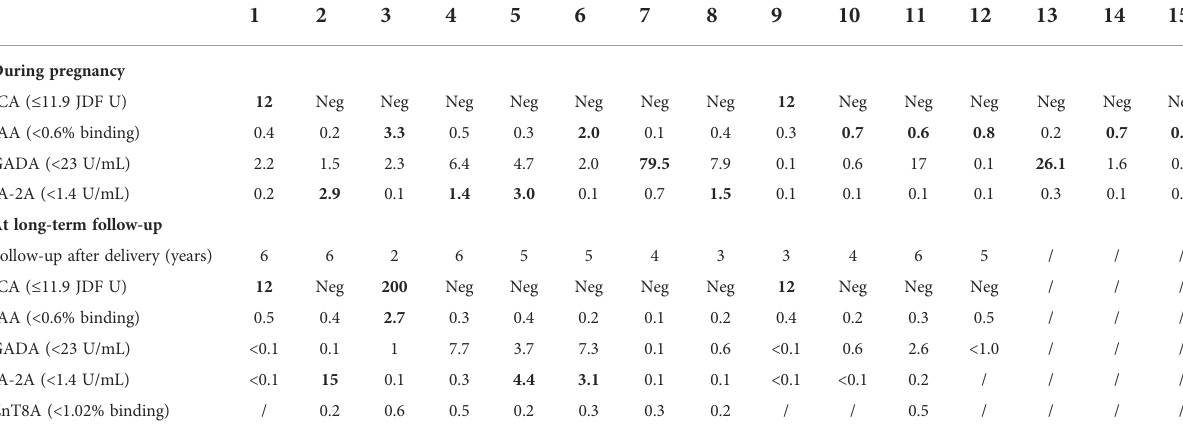
TABLE 1 Levels of T1D-related autoantibodies in women with GDM in pregnancy and at long-term